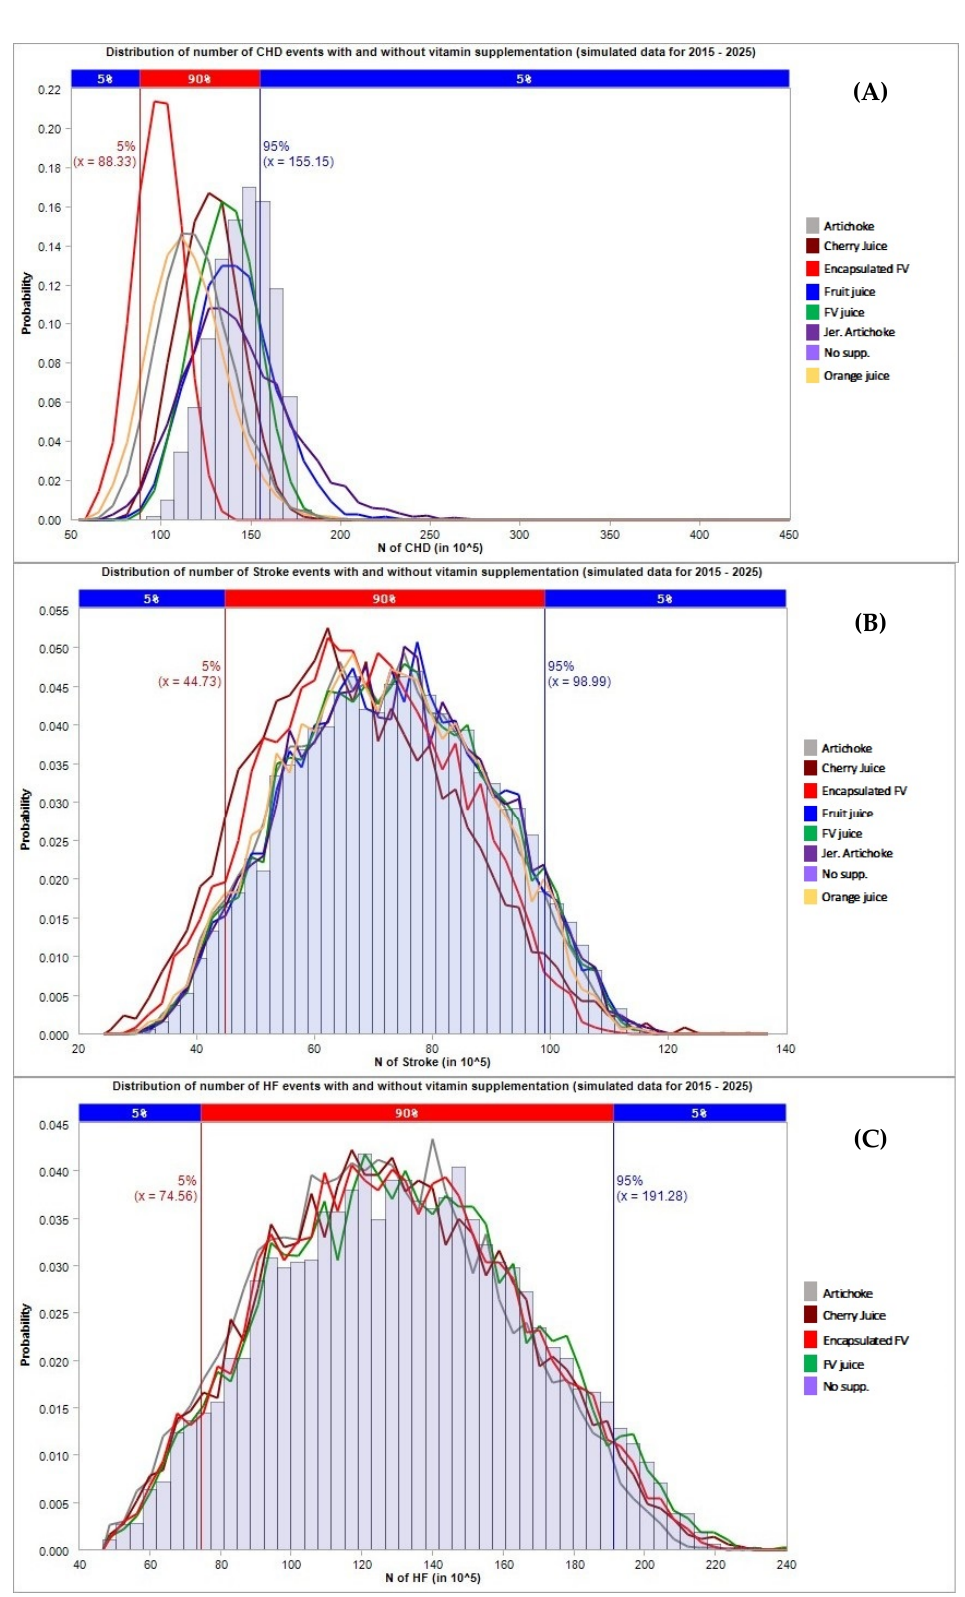
Figure 3. Number of cardiovascular events avoided under different supplementation regimes (estimates for the population with hypertension). The first chart ( A ) refers to CHD cases, the second chart ( B ) refers to stroke cases, the third chart ( C ) refers to HF cases.